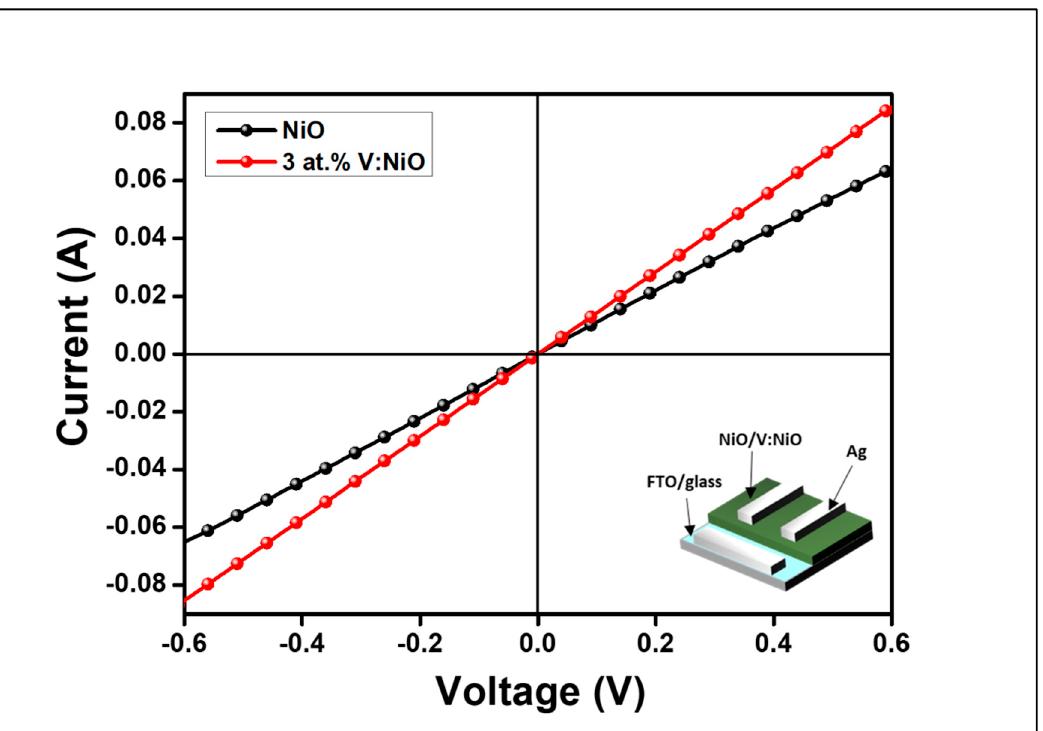
Figure 7. I–V curves of NiO and 3 at.%V:NiO films based on the structure of FTO/NiO or 3 at.%V:NiO/Ag; the inset shows the corresponding fabricated electrode structure.